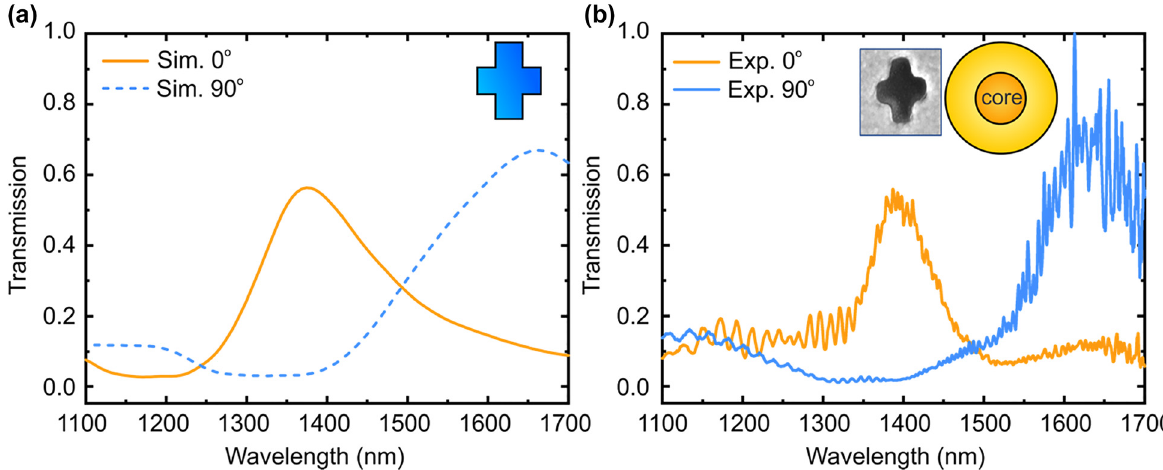
Figure 5: Transmission spectra for SMF metasurface optical filter. (a) Simulated and (b) measured transmission spectra for x - and y -polarization states for SMF with asymmetric nanocross metasurfaces. Asymmetric nanocross consists of unit element with wide of 193 nm and length of slit of 577 and 465